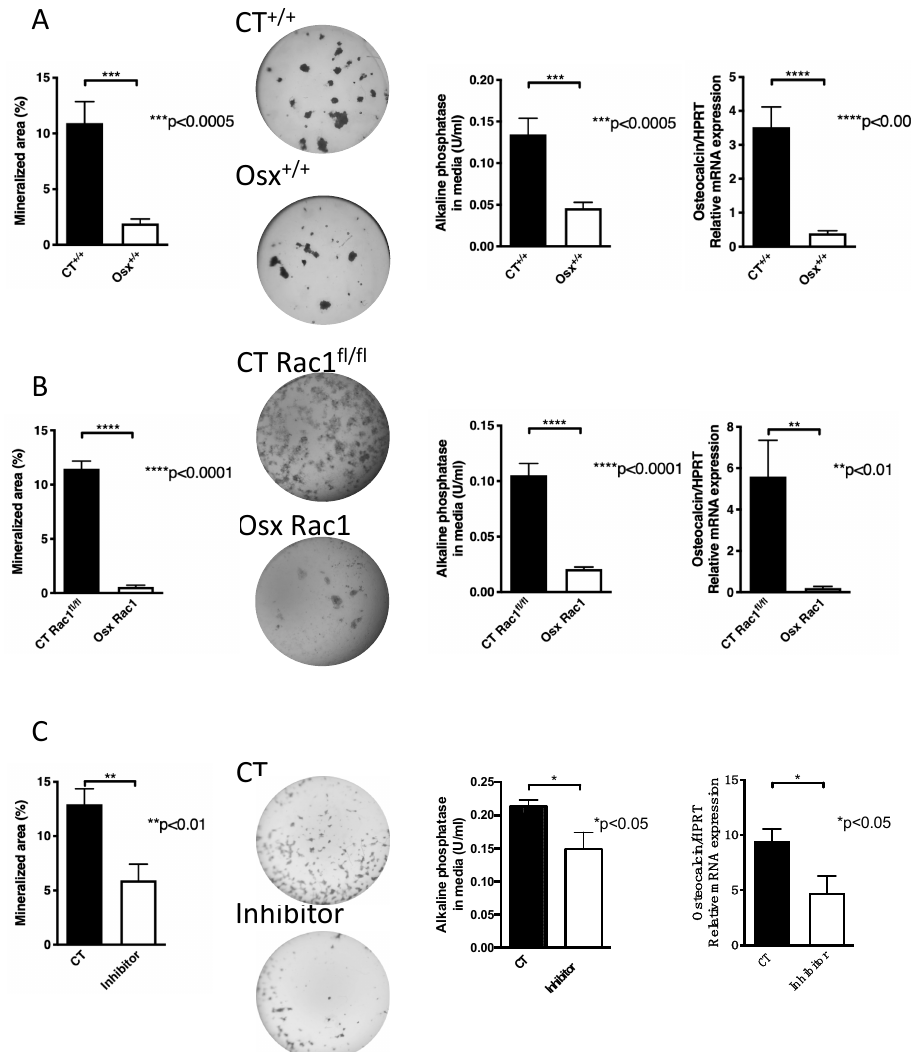
Figure 2. Inhibition of Rac1 affects osteoblasts. ( A ) The expression of osterix to drive Cre recombinase without deletion of Rac1 (Osx +/+ ) in newborn calvarial osteoblasts suppresses their differentiation in vitro compared to littermate controls not carrying any gene (CT +/+ ). Newborn calvarial osteoblasts were isolated and cultured for 2-3 weeks in the mineralizing condition in the presence of vitamin C, β -glycerophosphate, and dexamethasone added fresh with each medium change (3 times/week). At the end, the wells are stained with von Kossa, the media evaluated for alkaline phosphatase, and mRNA from the cells evaluated for osteocalcin mRNA expression adjusted to HPRT. The mice were not exposed to doxycycline at any time pre- or postnatally. n = 19/16, 20/20, and 17/20. ( B ) Deletion of Rac1 using osterix-driven Cre recombinase (Osx Rac1) leads to diminished mineralization, alkaline phosphatase and osteocalcin/HPRT compared to littermate controls (CT Rac1 fl/fl ). The mice were not exposed to doxycycline at any time pre- or postnatally. n = 12/19, 32/32, and 3/5. ( C ) Using a chemical inhibitor of Rac1 (EHT1864) added with each medium change at a final concentration of 5 μ M suppressed differentiation of newborn calvarial osteoblasts as evidenced by suppressed nodule formation in cultures stained with von Kossa, suppressed alkaline phosphatase in the conditioned media and lower levels of osteocalcin/HPRT mRNA expression compared to control cells treated with phosphate-buffered saline (PBS) containing dimethylsulfoxide (DMSO) at the same concentration as the inhibitor. n = 10/15, 19/19, 12/12. The values were compared between every two groups in all subpanels using t -tests.